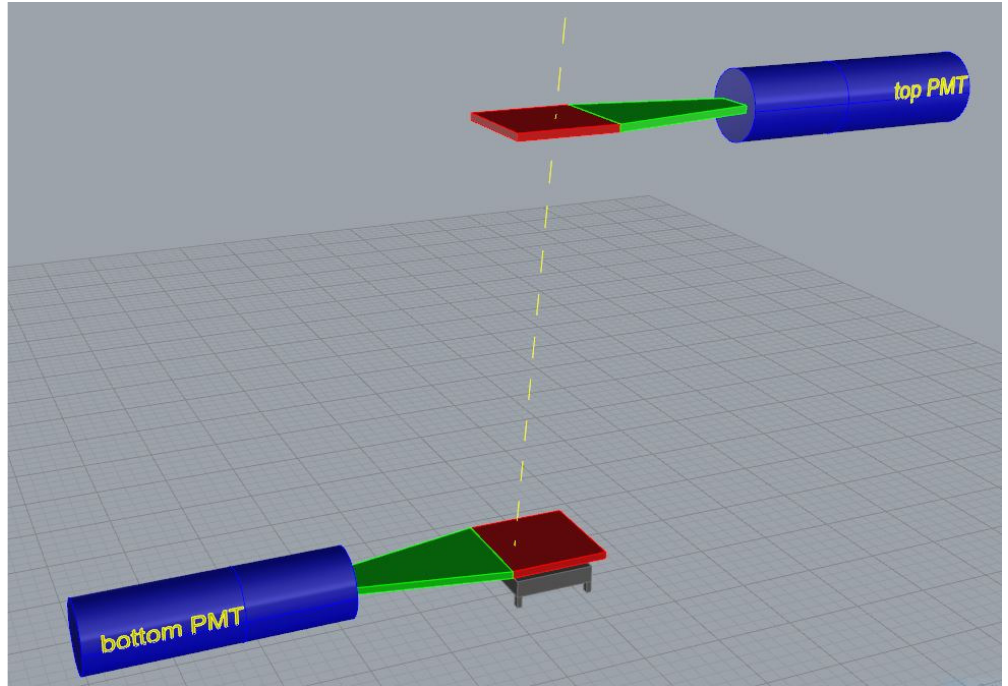
Figure 5. 3D sketch, not to scale, of the experimental setup for the test of Cherenkov-tag prototype. In order to more easily distinguish each component of the trigger system, they are differently colored: Photo-Multiplier tubes (PMTs) are blue, light guides are green and the scintillating tiles are